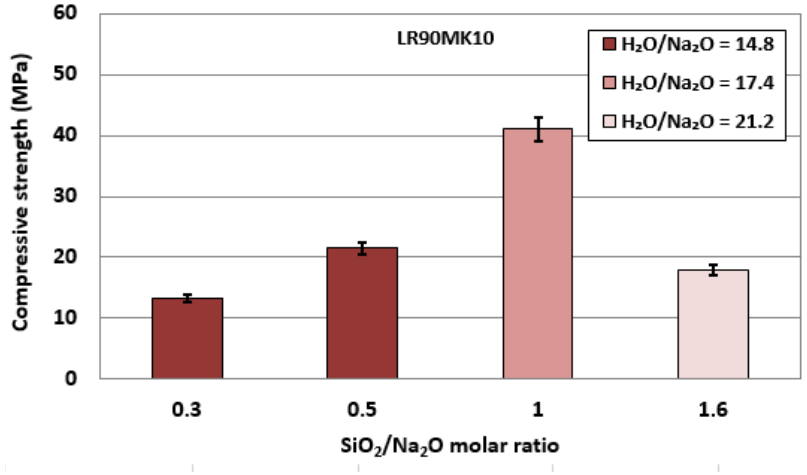
Figure 3. Effect of SiO 2 /Na 2 O molar ratios in relation to the corresponding H 2 O/Na 2 O molar ratios in the activating solution on the compressive strength of LR90MK10 AAMs (pre-curing time, 4 h; curing temperature, 80 ◦ C; curing period, 24 h; ageing period, 7 days; error bars denote standard deviation of measurements obtained from three specimens).